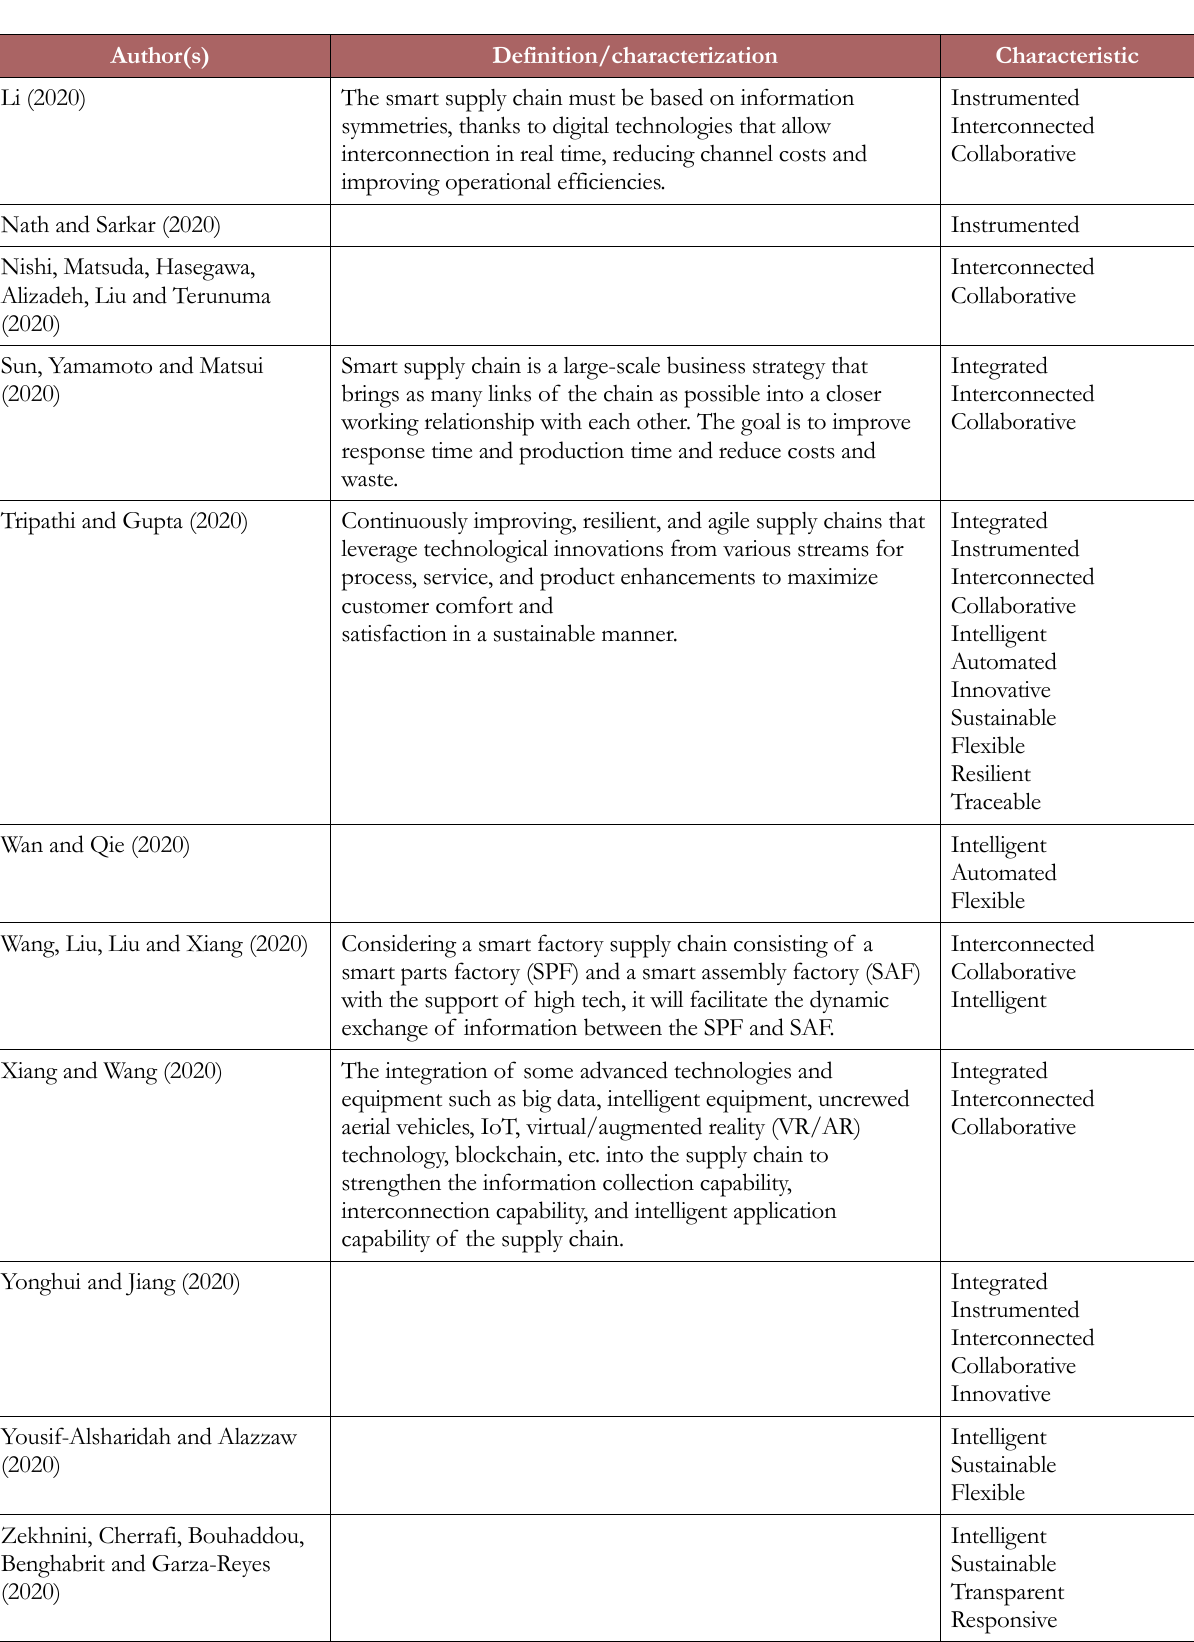
Table 2. Definitions and characteristics of smart supply